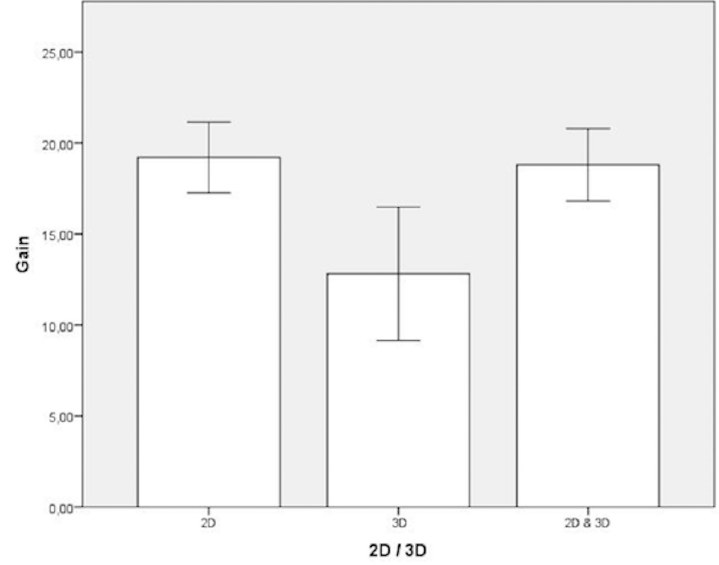
Figure 4. Mean gains as a function of dimensions with a 95% confidence interval.